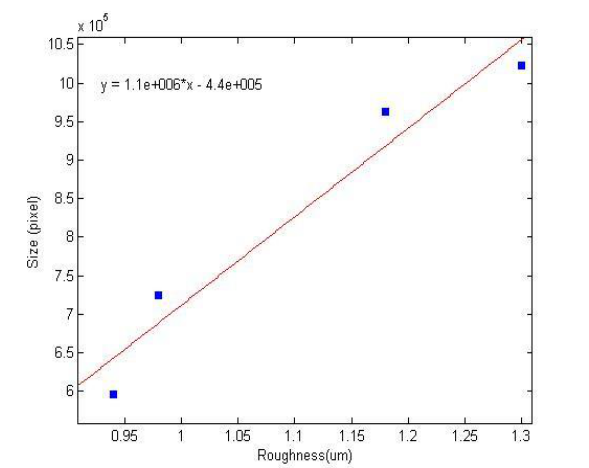
Fig. 8: The counts of pixels as a function of roughness .